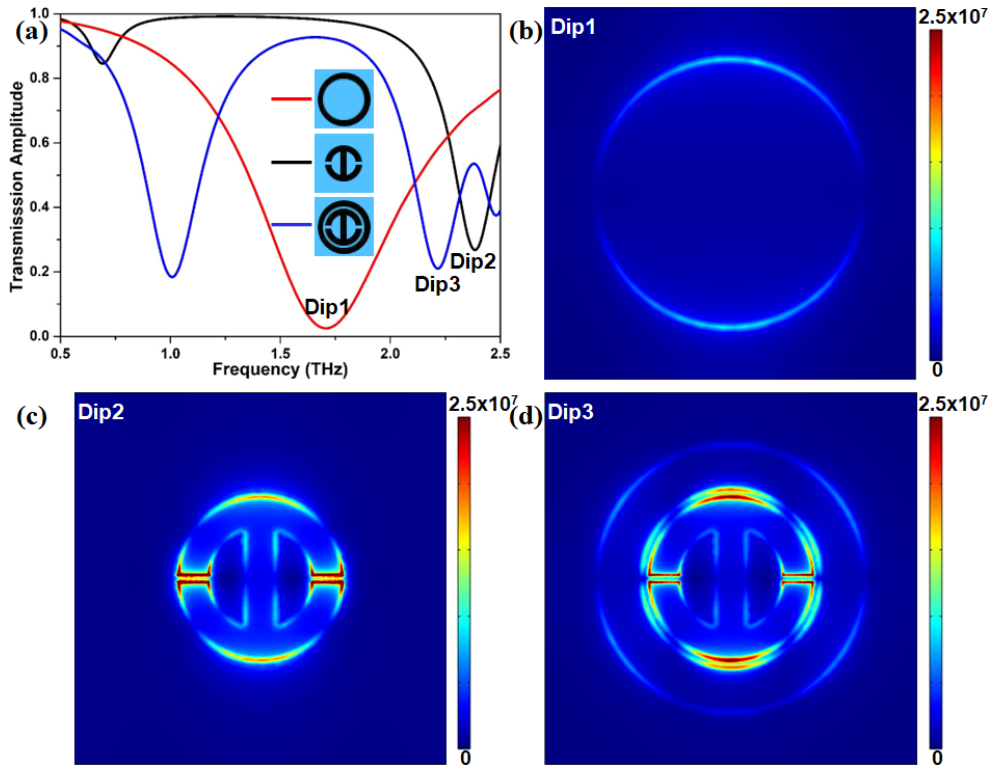
Figure 2. ( a ) Normalized THz transmission amplitudes of the graphene ring, H-shaped structure, and both of them. ( b , d ) Distributions of electric field at frequency points Dip1, Dip2, and Dip3. These three points are corresponded to the frequencies: ( b ) 1.70 THz, ( c ) 2.38 THz, and 2.2 THz,